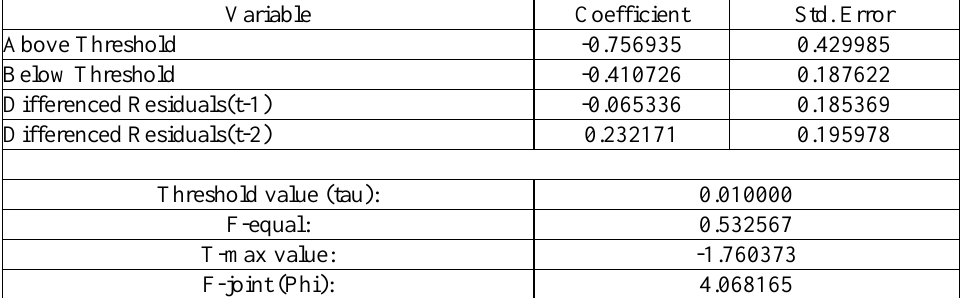
Table 6. Asymmetric convergence using TAR